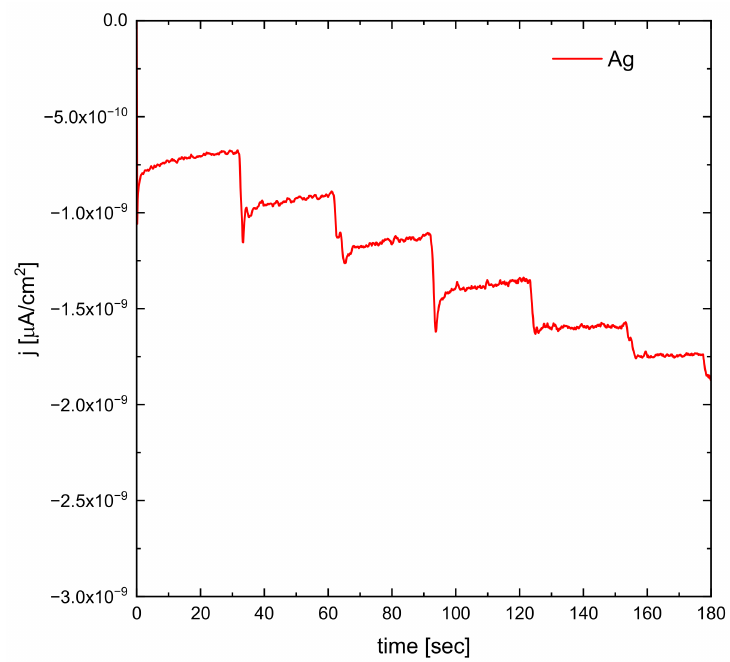
Figure 17. Amperometric measurement of hydrogen peroxide reduction with silver